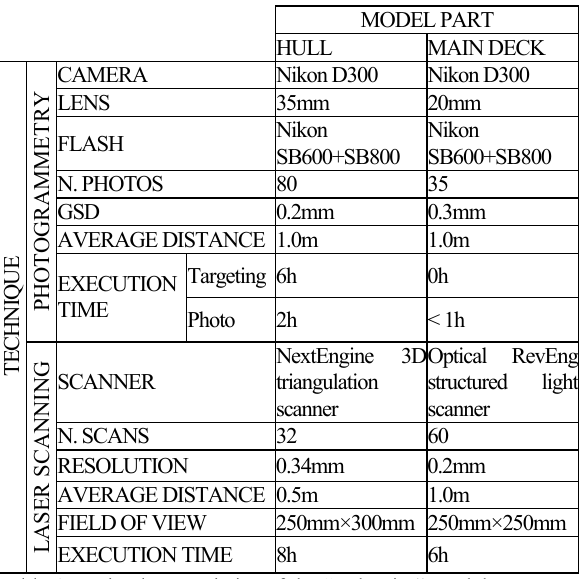
Table 1: Main characteristics of the “Indomito” model survey.